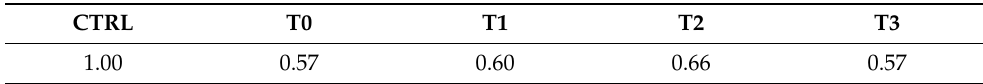
Table 4. IFN scores calculated through the median of the relative quantifications of the six interferon-stimulated genes (ISGs) of the interferon signature analysis after administration of higher-dose sulforaphane (SFN) supplement in the second healthy volunteer (HV2).